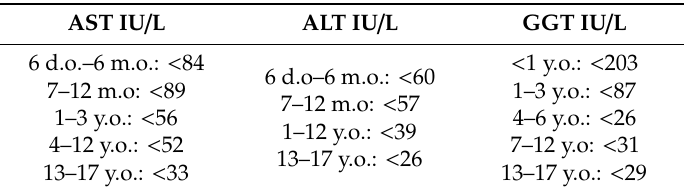
Table 2. Norms used in our